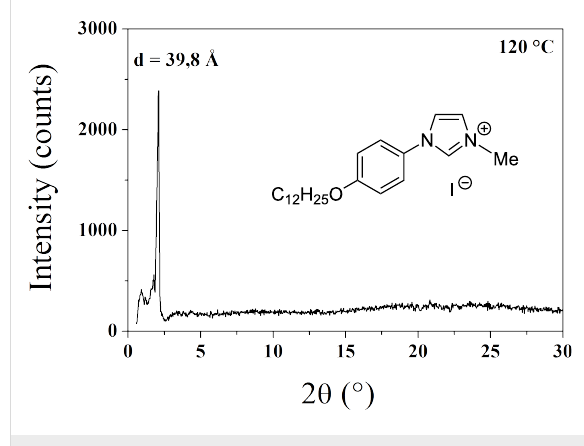
Figure 6: Powder X-ray diffraction pattern of compound 1a in the liquid crystal state (T = 120 °C).